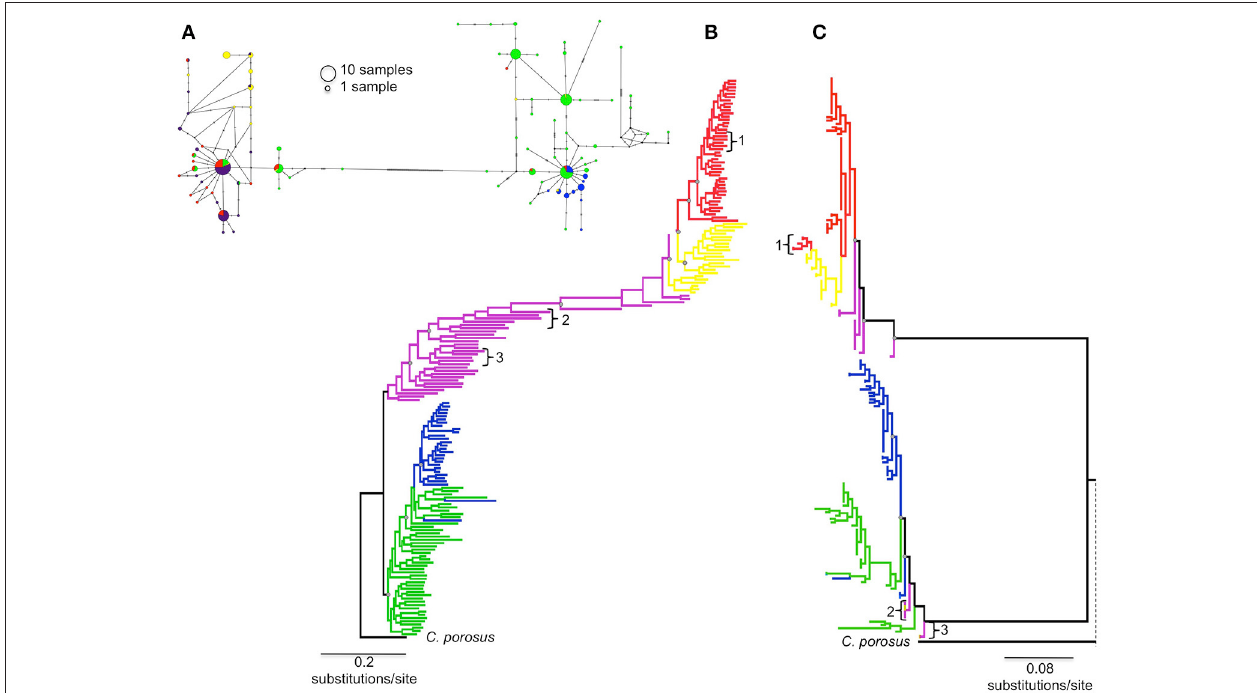
FIGURE 4 | Haplotype, mitochondrial, and genealogical relationships among Crocodylus species. (A) Minimum haplotype network based on the mtDNA haplotypes for Crocodylus acutus and C. moreletii from Mexico. Circles represent haplotypes and circle size is proportional to haplotype frequency. Color of circles represents the proportion of individuals based on the STRUCTURE ( K = 5) and the phylogenetic results (see Figure 2 ). (B) Maximum-likelihood phylogenetic tree based on the biallelic SNPs and (C) on the concatenated mtDNA, with Crocodylus porosus as outgroup. Colors on the network and trees indicate the assignment of each individual into the five SNP-based genetic clusters: non-admixed C. moreletii (blue), hybrids (green), Yucatan peninsula hybrids (purple), non-admixed Caribbean islands C. acutus (yellow), and non-admixed Pacific C. acutus (red). Gray-filled circles indicate high bootstrap support ( > 75%). Numbers (1, 2, 3) highlight key “switches” of individuals between SNPs and mtDNA topologies (see Results for